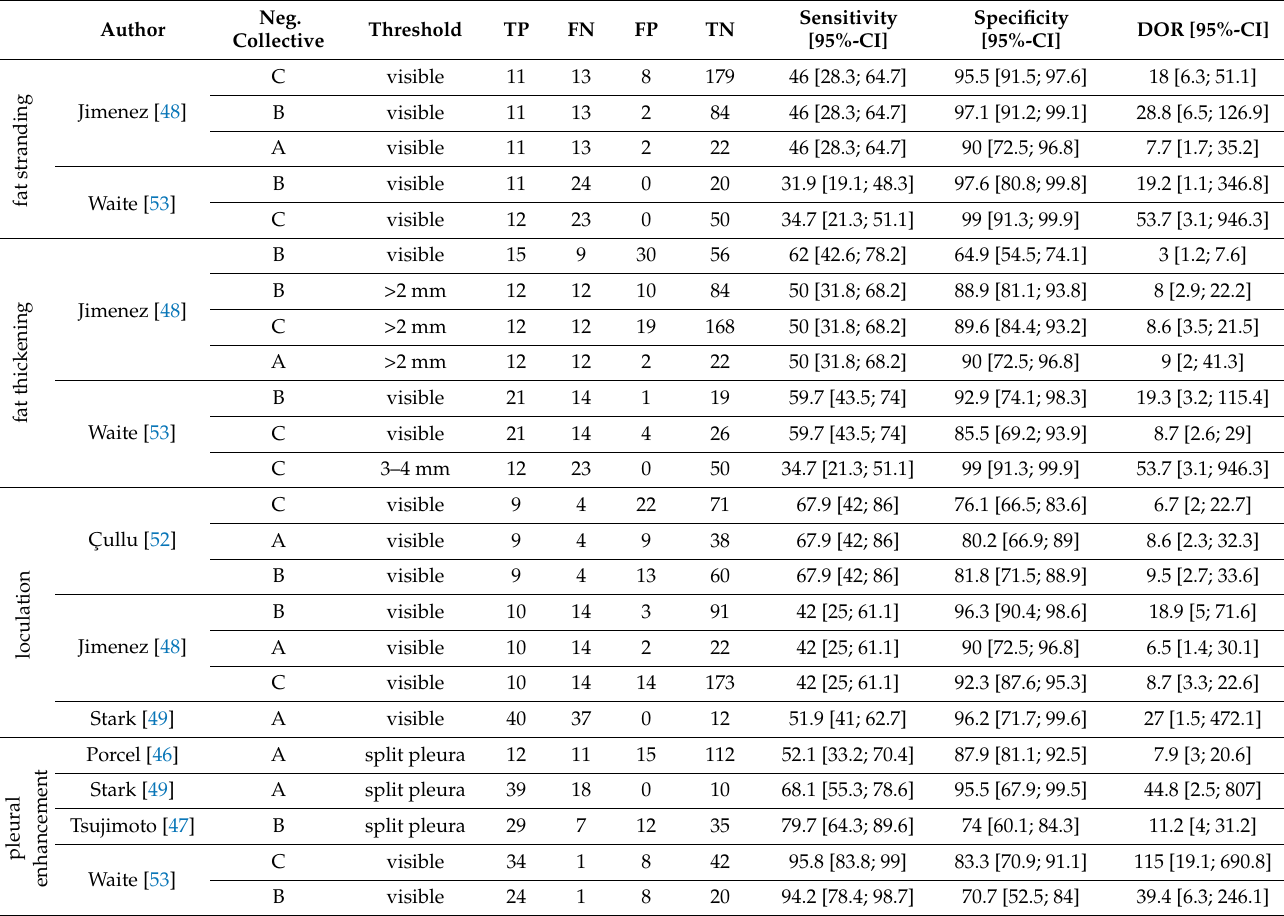
Table A3. Categorization of pleural findings, sensitivities, and